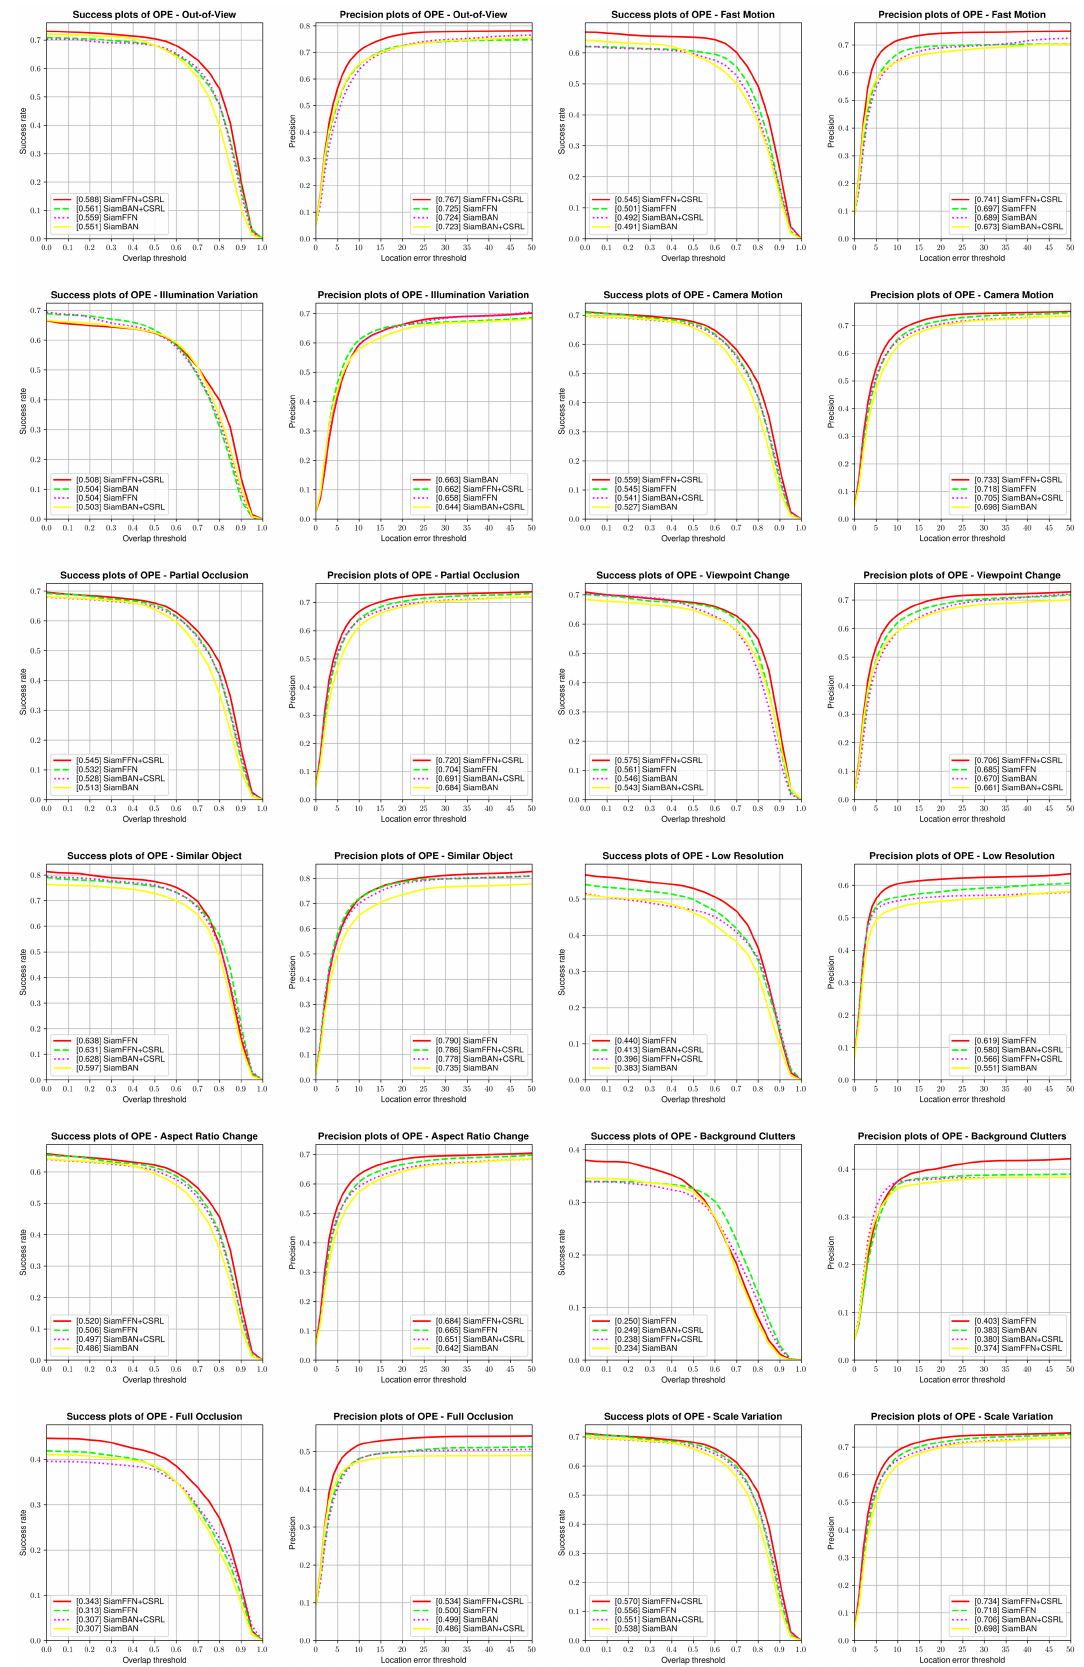
Figure 8. Tracking output of attribute analysis on